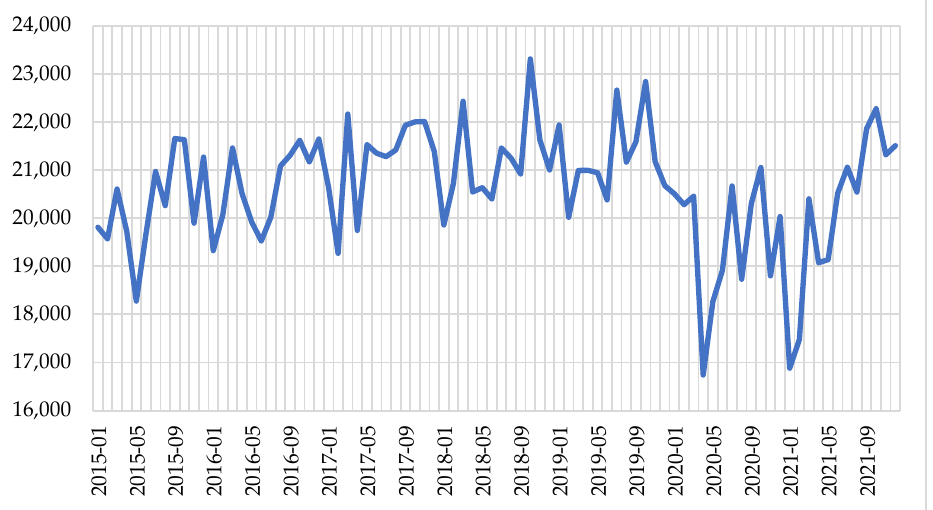
Figure 5. Changes in the volume of gas oil and diesel oil supplies to EU countries (in thousand tonnes). Source : own elaboration.